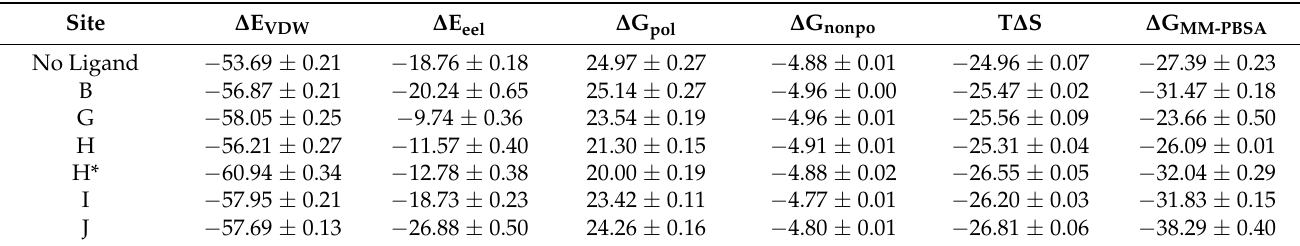
Table 4. Energy decomposition of MM-PBSA-WSAS free energy for CP55940 binding to CB2 with C-2, an allosteric agonist existing. All energies are in kcal/mol. H* implies that the C-2 is considered as a part of the receptor.